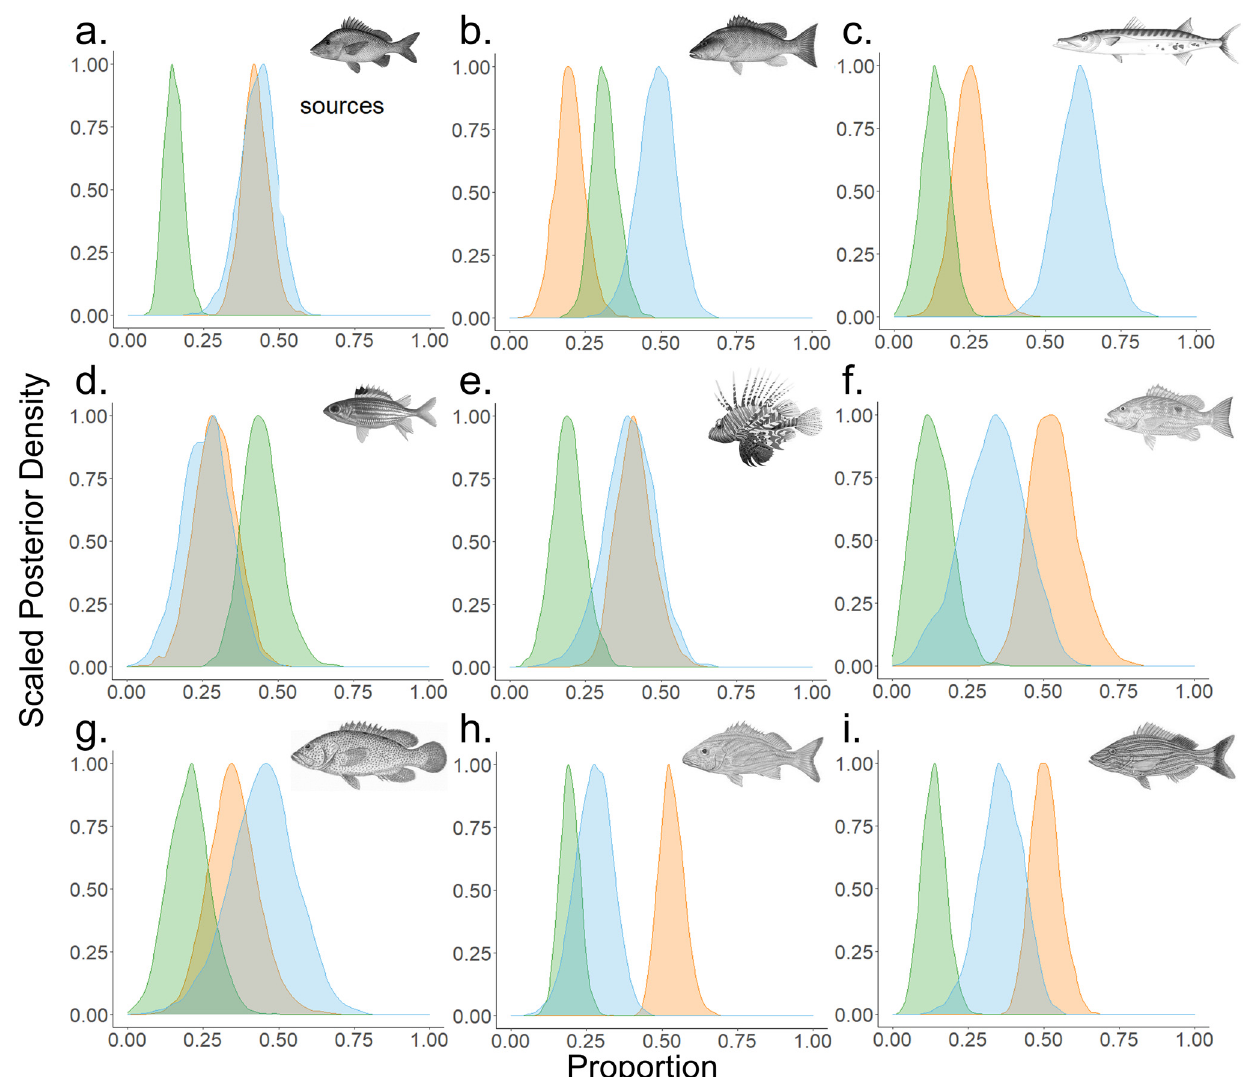
Figure 6. Relative contribution estimates of three dominant primary producers (POM (blue), BMA/seagrass (orange), mangrove (green)) for nine fish species. Plots outputs from MixSIAR models. Fish species are ( a ) white grunt, ( b ) schoolmaster snapper, ( c ) great barracuda, ( d ) squirrelfish, ( e ) red lionfish, ( f ) lane snapper, ( g ) graysby, ( h ) French grunt, and ( i ) bluestriped grunt.